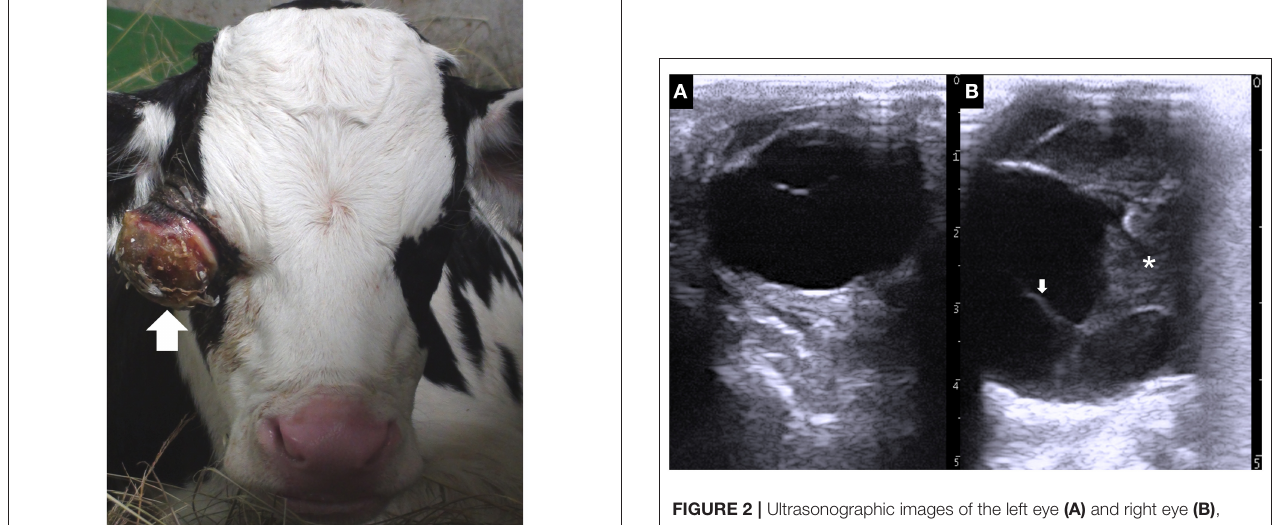
FIGURE 1 | Photo of the front of the face of the 7-day-old male Holstein calf, showing the enlarged eyeball (arrow) protruding from the right eye-socket.